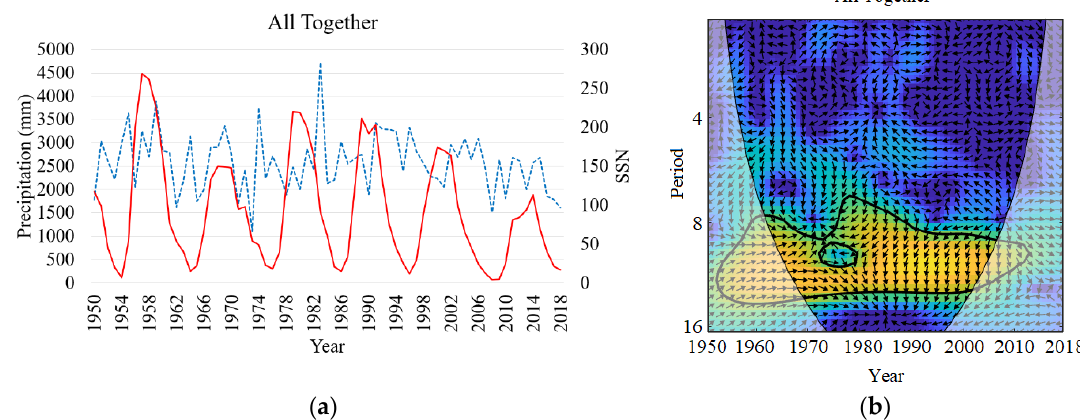
Figure 5. ( a ) SSN and MAP of all stations combined, and ( b ) the XWT analysis result of the two time series.